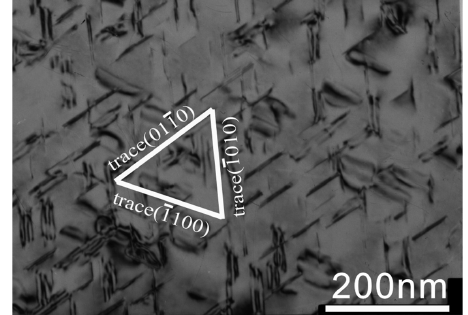
Figure 1: Bright field TEM images of Ti-2.5Cu alloy after duplex